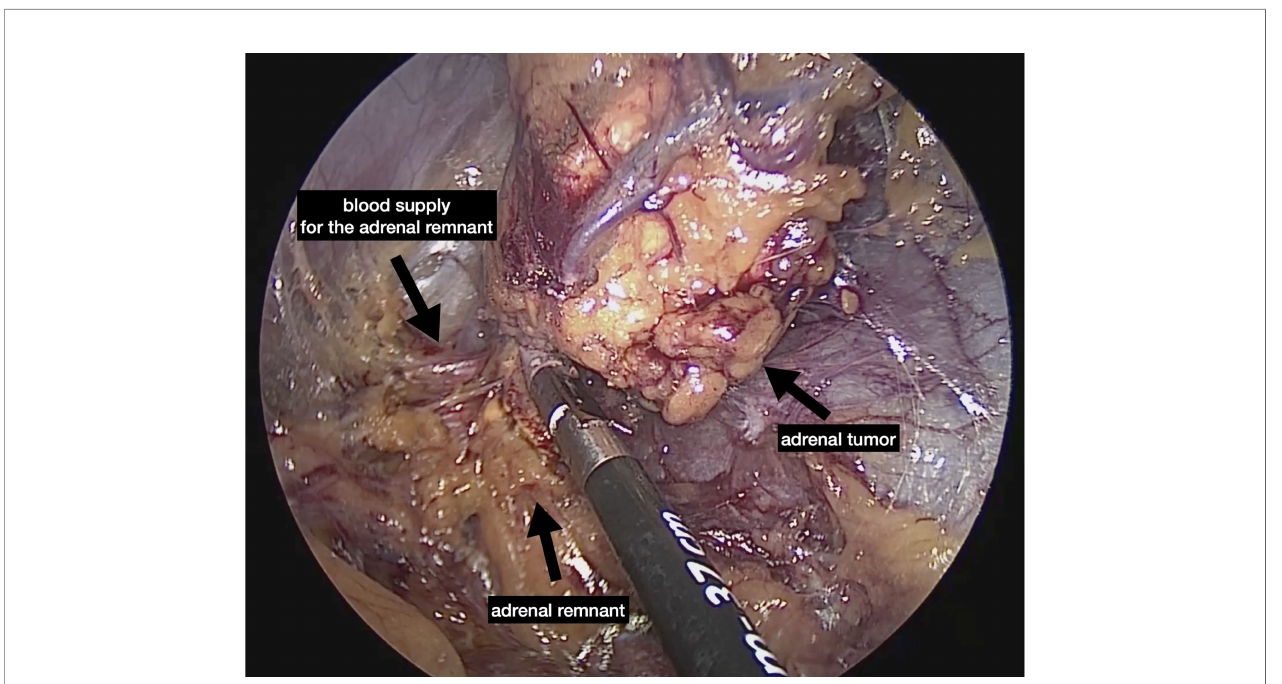
FIGURE 4 | Division of the gland performed by bipolar instrument.